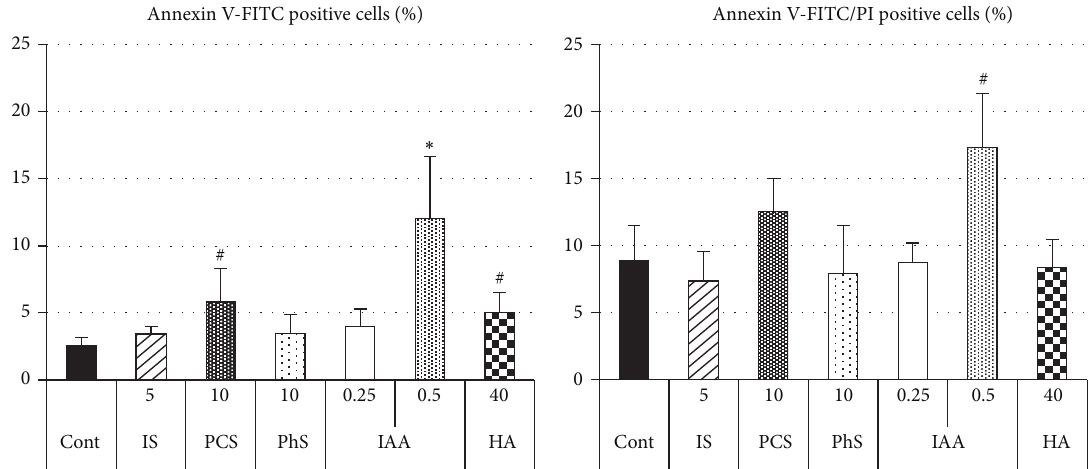
Figure 4: Effects of uremic solutes on cell death. After 48-hour incubation with each uremic solute, porcine renal tubular cells were stained with annexin V-FITC and propidium iodide (PI). Percent of annexin V-positive cells and annexin V/PI-positive cells was analyzed and calculated. Cont, control; IS, indoxyl sulfate; PCS, p -cresyl sulfate; PhS, phenyl sulfate; HA, hippuric acid; IAA, indoleacetic acid. Data are shown as mean ± S.D. ( 𝑛 = 4 ). Asterisk indicates significant difference compared to corresponding control ( 𝑃 < 0.01 ). Sharp marks (#) indicate 𝑃 < 0.05 .